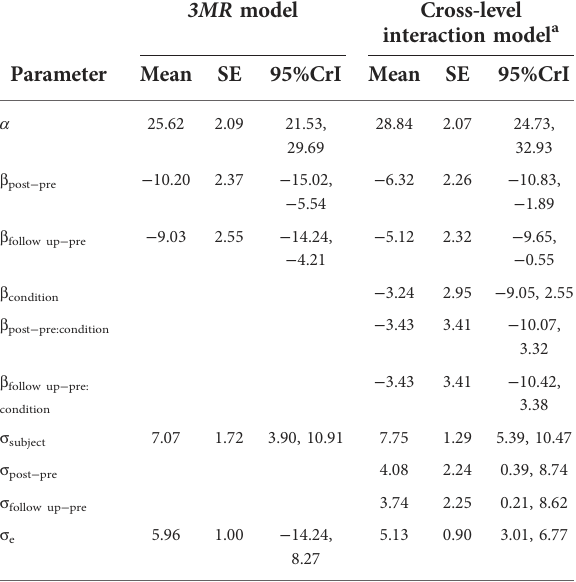
TABLE 5 Posterior mean, standard error, 95% credible interval for each parameter in model predicting BDI-II